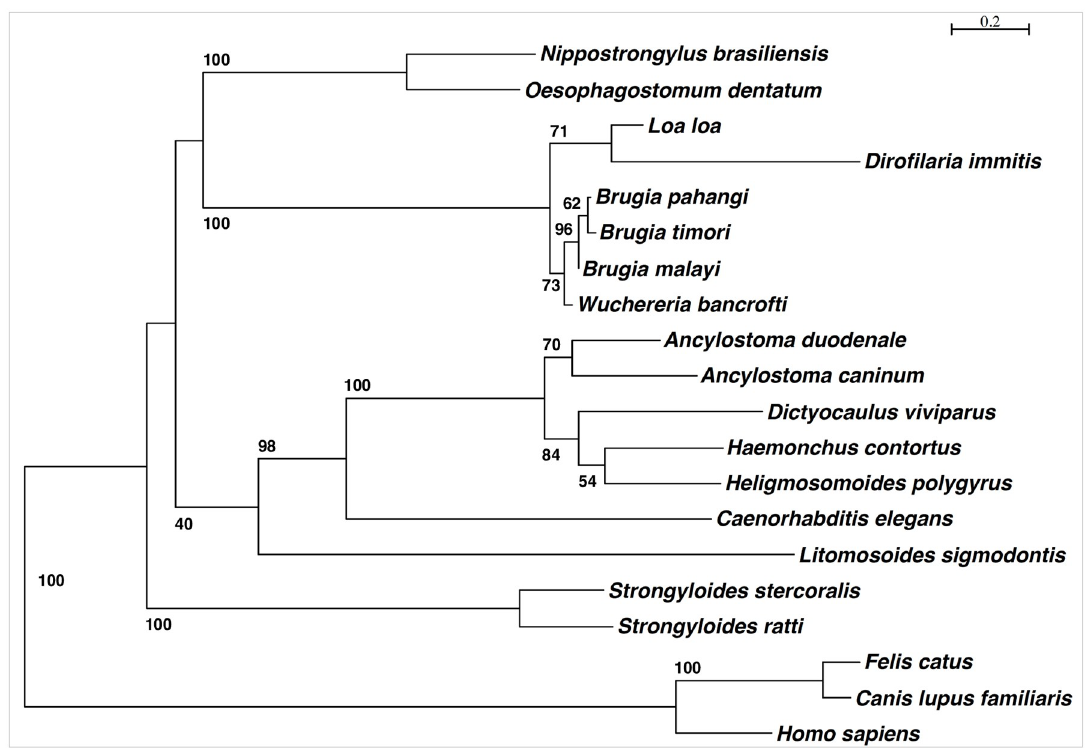
Fig 1. Phylogenetic comparison of Bm-UGT. Based on the B . malayi cDNA sequence alignment, there is a high level of relatedness to other filarial species for Bm-UGT and vast evolutionary distance to cat, dog, and human UGT molecules. The sequence alignment was generated using MUltiple Sequence Comparison by Log-Expectation (MUSCLE) performed by software SeaView. The tree was constructed based on the maximum likelihood method. The phylogenetic scale indicates genetic change as measured by the number of nucleotide substitutions per site.